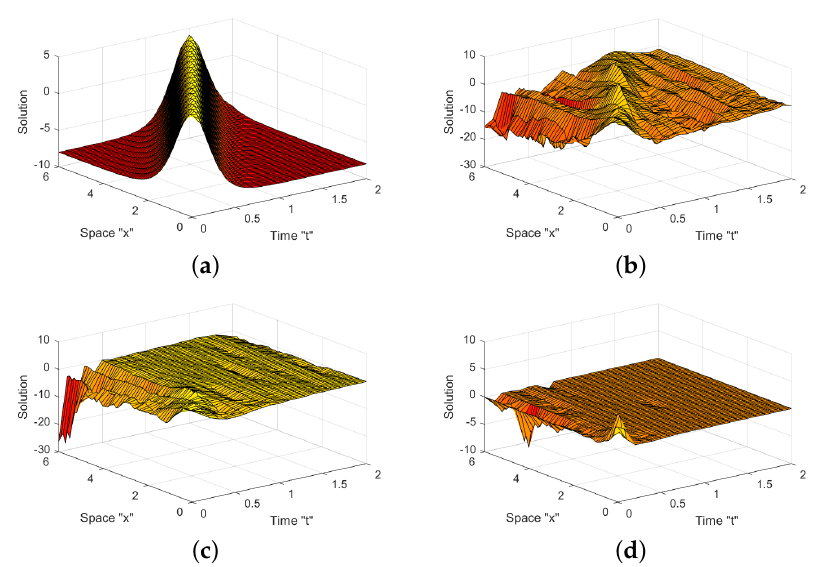
√ 13, indicate the 3D profiles ( a )